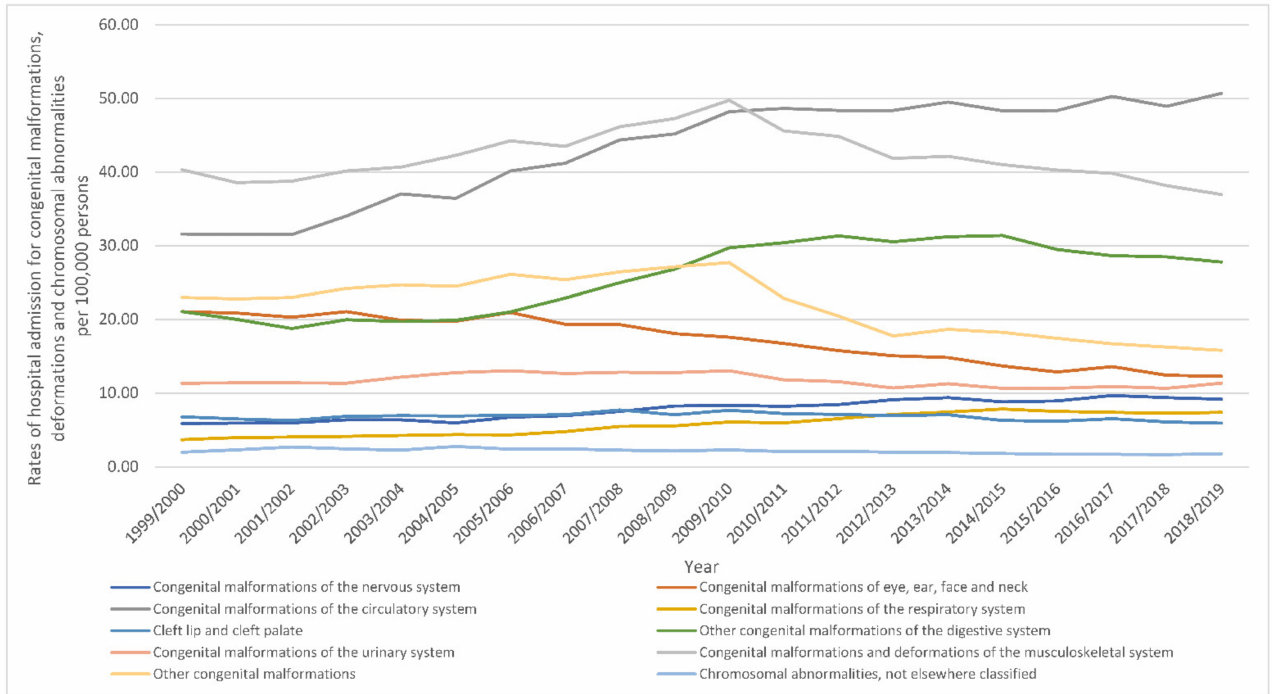
Figure 7. Rates of hospital admission for congenital malformations, deformations and chromosomal abnormalities in England and Wales stratified by type between 1999 and 2019 excluding gender-specific